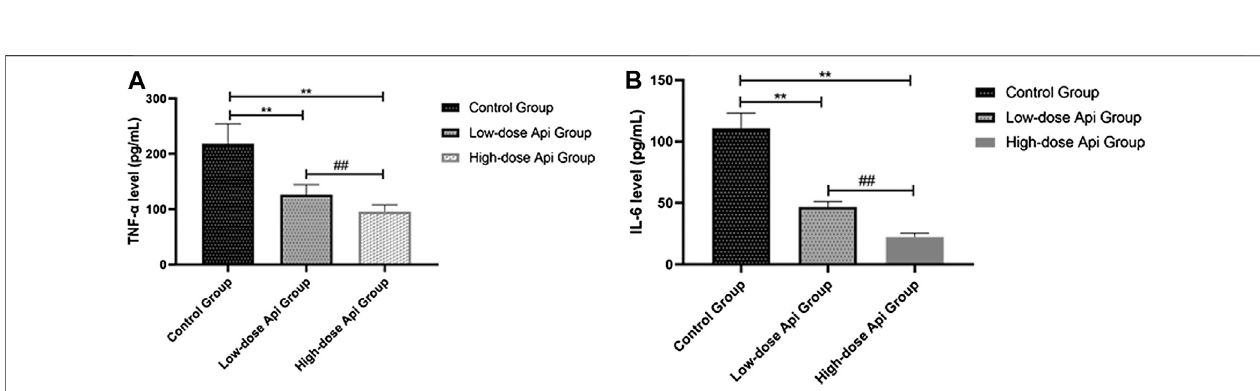
FIGURE7| SerumlevelsofTNF- α (A) andIL-6 (B) 7 daysaftertheoperationasdetermined byELISA.ApiinhibitedtheexpressionofTNF- α andIL-6.** p < 0.01vs. control group. ## p < 0.01 vs. Low-dose Api group.